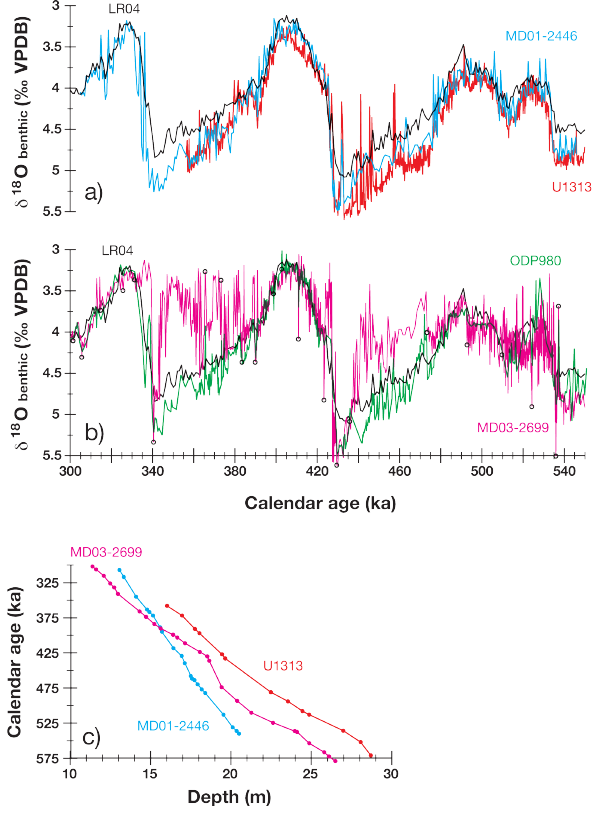
Fig. 2. (a) Benthic δ 18 O records of IODP Site U1313 (red) and MD01-2446 (cyan) in comparison to the LR04 stack (black) (Lisiecki and Raymo, 2005); (b) Benthic δ 18 O record of MD03- 2699 (magenta) in comparison to ODP site 980 (green; on LR04 timescale) and the LR04 stack (black). Black circles on the MD03- 2699 record mark age control points (Table 2). (c) Age-depth rela- tionships for IODP Site U1313 and cores MD01-2446 and MD03- 2699.